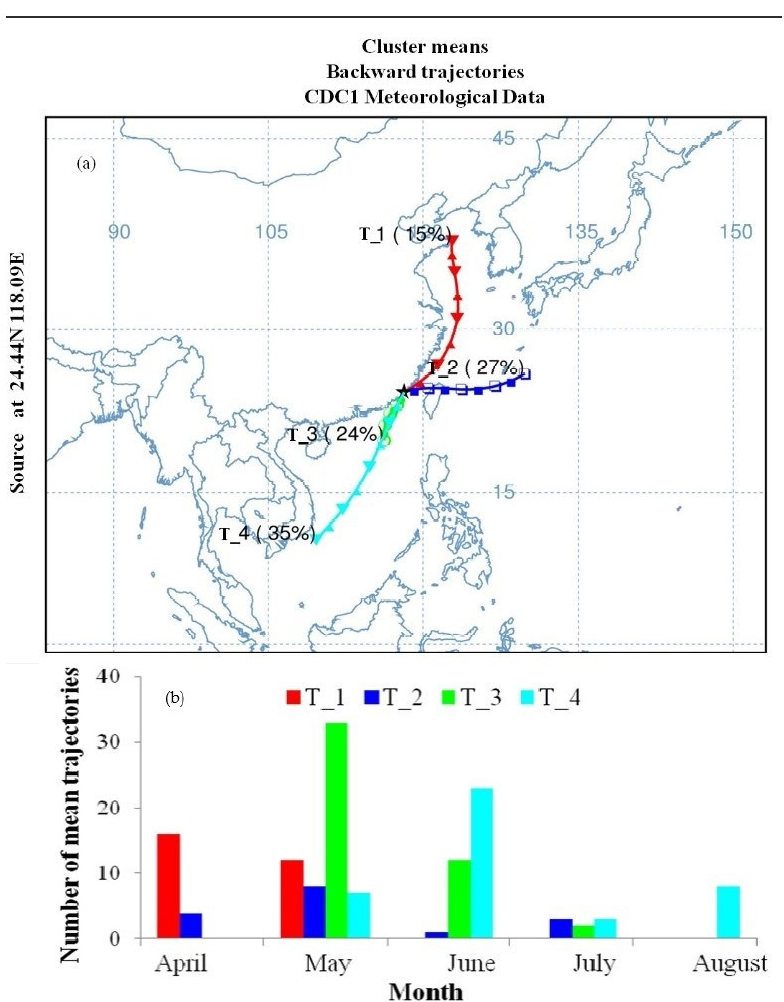
Figure 6. ( a ) Cluster mean trajectories ending site and ( b ) monthly distributions during sampled precipitation events from April to August [23] .